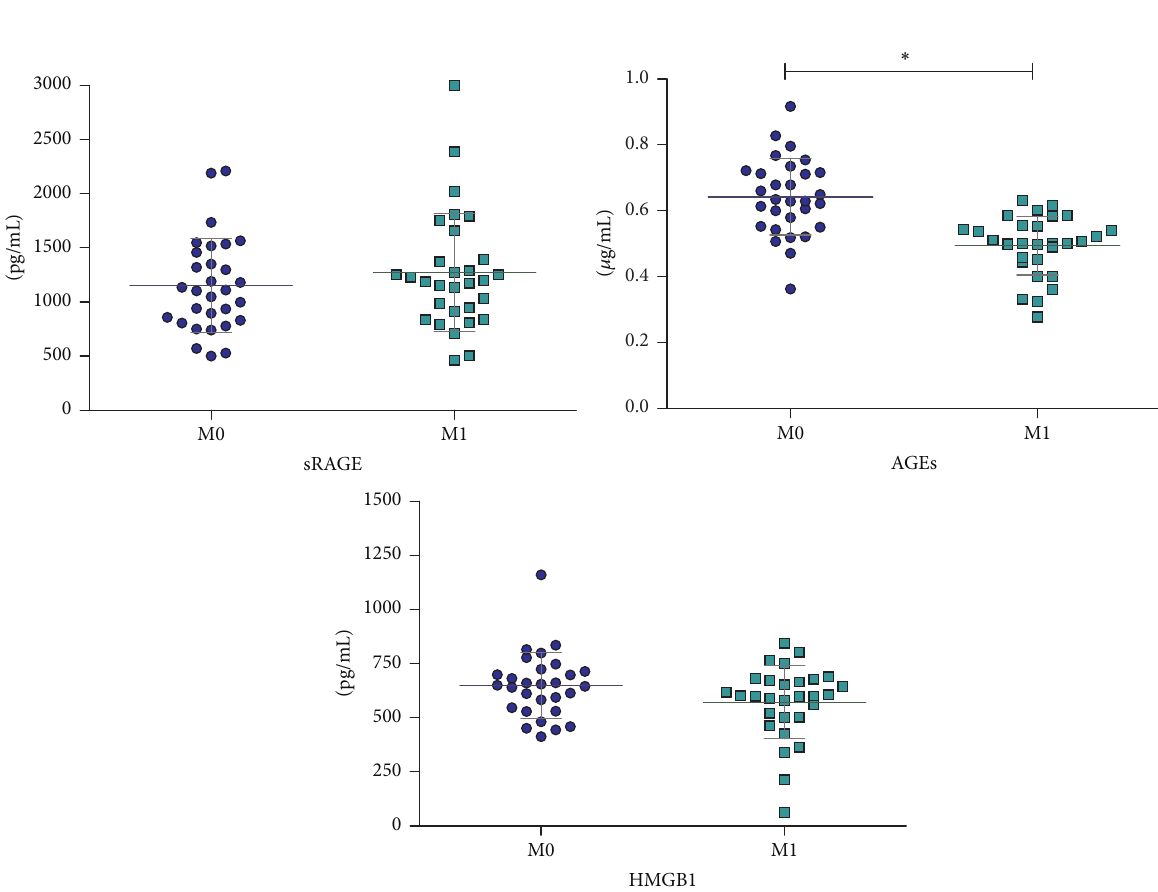
Figure 2: Plasma levels of RAGEs, AGEs, and HMGB1 of 30 PLWHA, before and after cART initiation. PLWHA: people living with HIV/AIDS; cART: combined antiretroviral therapy; AGEs: advanced glycation end products; sRAGE: soluble receptor of AGEs; HMGB1: high mobility group box protein-1. M0: before cART initiation; M1: after cART initiation. Statistical tests: ANOVA with post hoc Tukey’s tests. ∗ 𝑝 < 0.0001